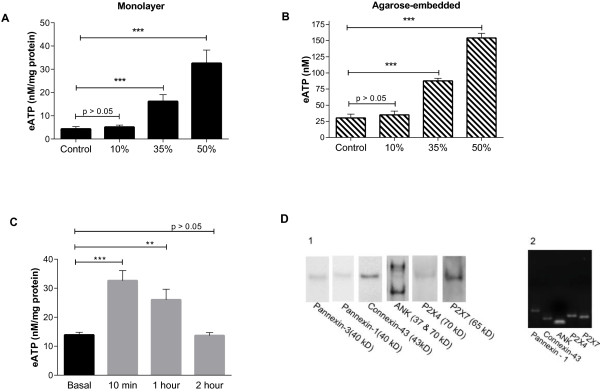
Effect of a hypotonic challenge on eATP levels in media from monolayer and agarose cultures and characterization of putative ATP transport participants. (A) Normal adult porcine chondrocytes were plated in high-density short-term monolayer cultures. Media were replaced with fresh media (control) or identical quantities of media containing increasing percentages (volume/volume) of H2O. eATP levels were measured 10 minutes post-treatment. Bars represent mean ± standard error (A-C). eATP levels were increased by 35 and 50% H20 compared to an undiluted media control (n = 8;***P <0.001). (B) Chondrocytes were embedded in 2% agarose. Media were replaced with fresh media (control) or identical quantities of media containing increasing percentages (volume/volume) of H2O. eATP levels were measured 10 minutes after the media change. eATP levels were increased by 35 and 50% H20 compared to undiluted media control (n = 8;***P <0.001). (C) Chondrocytes were exposed to hypotonic media (gray bars) or isotonic media (black bars) for various lengths of time and eATP levels were measured. eATP levels were increased compared to unchallenged control at 10 minutes and 1 h (n = 8;***P <0.001, **P <0.01). D. Chondrocyte protein extracts were run in western blots using specific antibodies against pannexin 1 and 3, ANK, P2X7 and P2X4. Total RNA was reverse transcribed and analyzed for mRNA for pannexin 1, ANK, P2X7 and P2X4 as described. The final PCR products were electrophoresed on a 1% ethidium bromide-stained agarose gel. Due to absence of a sequence for porcine pannexin-3, RT-PCR for pannexin-3 was not performed.